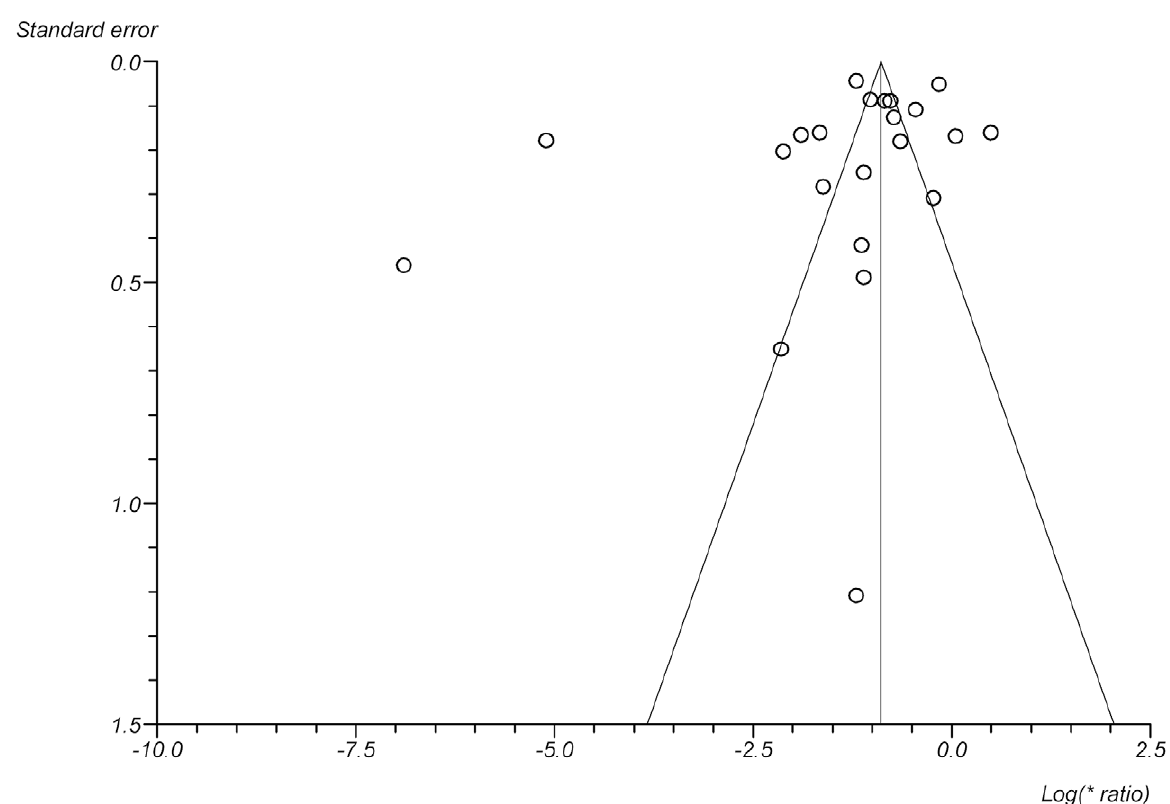
Figure 3. Funnel plot of standard error by log relative effectiveness.